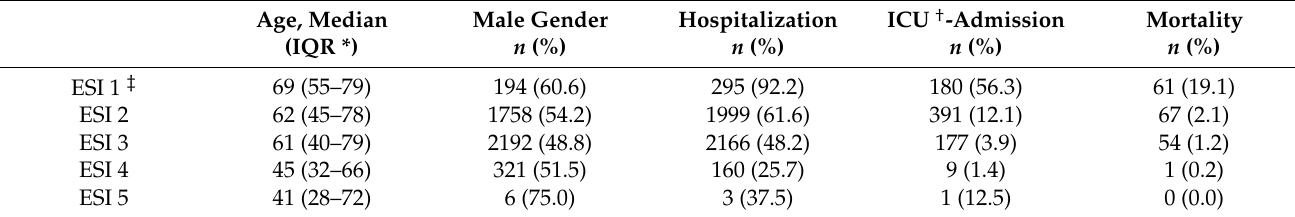
Table 2. Demographics and outcomes of patients included stratified by ESI level